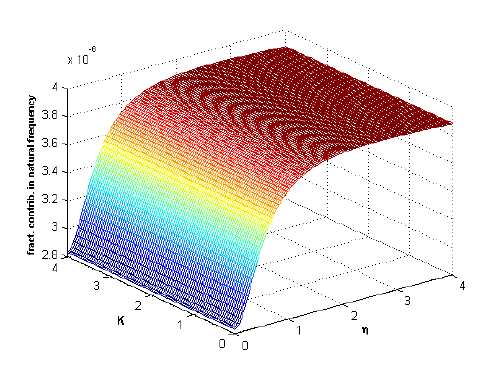
Figure 12. Fractional contribution frequency versus stiffness K and nonlocality η ( α = 0.8).